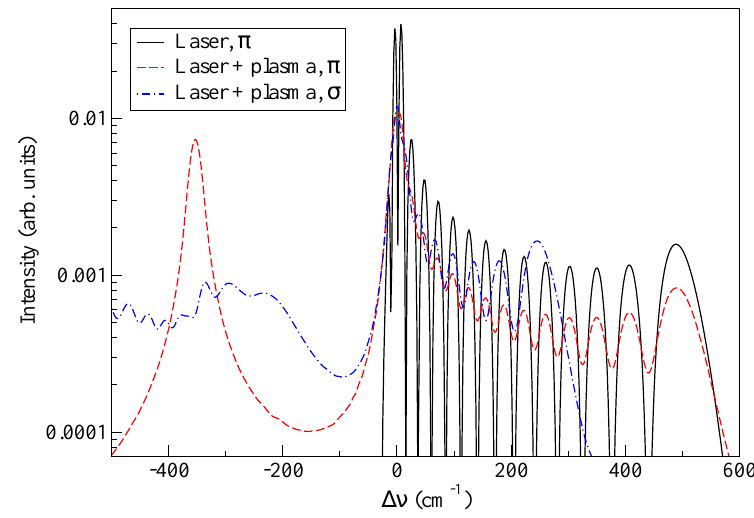
Figure 5. Spectra calculated under two scenarios: only laser perturbation and laser and plasma fields together. π and σ polarizations are shown separately. The settings assumed are the same as in Figure